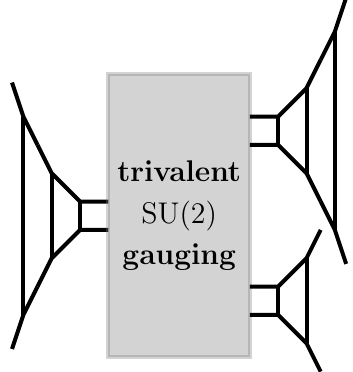
Figure 9 . A web-like description of the 5d theory which is dual to the pure E 6 gauge theory.